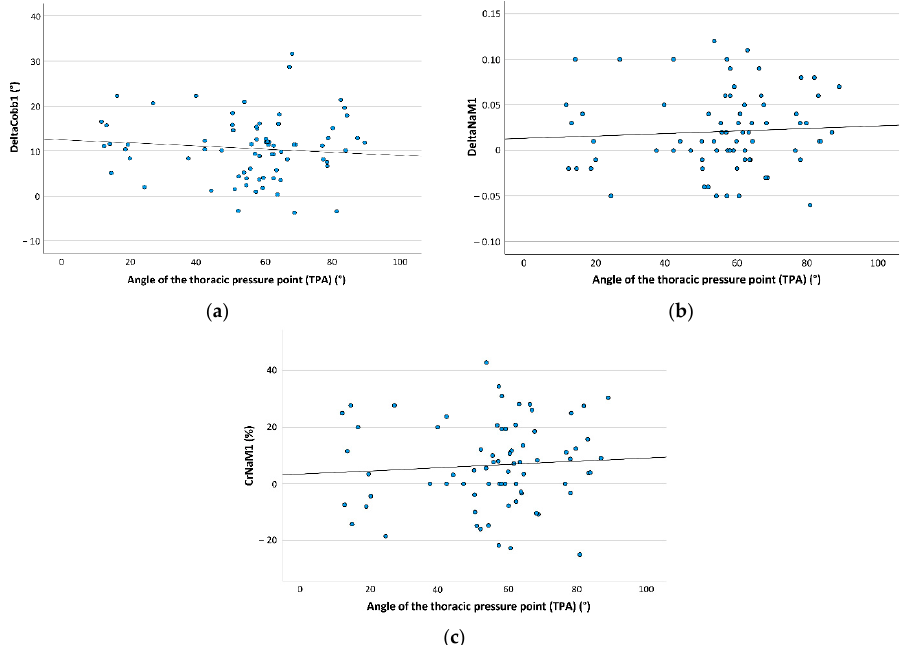
Figure 6. The figure demonstrates the distribution of mean angular Cobb (DeltaCobb1) and apex rotation correction (DeltaNaM1; correction rate CrNaM1) in relation to the angle of the thoracic pressure point angle (TPA), which were significant in multivariate general linear model (DeltaCobb1 p = 0.028, DeltaNaM1 p = 0.037, CrNaM1 p = 0.016). ( a ) The diagram shows TPA distribution in relation to DeltaCobb1. The black interpolated line demonstrates that with decreasing TPA, DeltaCobb1 increased. ( b ) The diagram shows TPA distribution in relation to DeltaNaM1. The black interpolated line demonstrates that with decreasing TPA, DeltaNaM1 decreased. ( c ) The diagram shows TPA distribution in relation to CrNaM1. The black interpolated line demonstrates that with decreasing TPA, CrNaM1